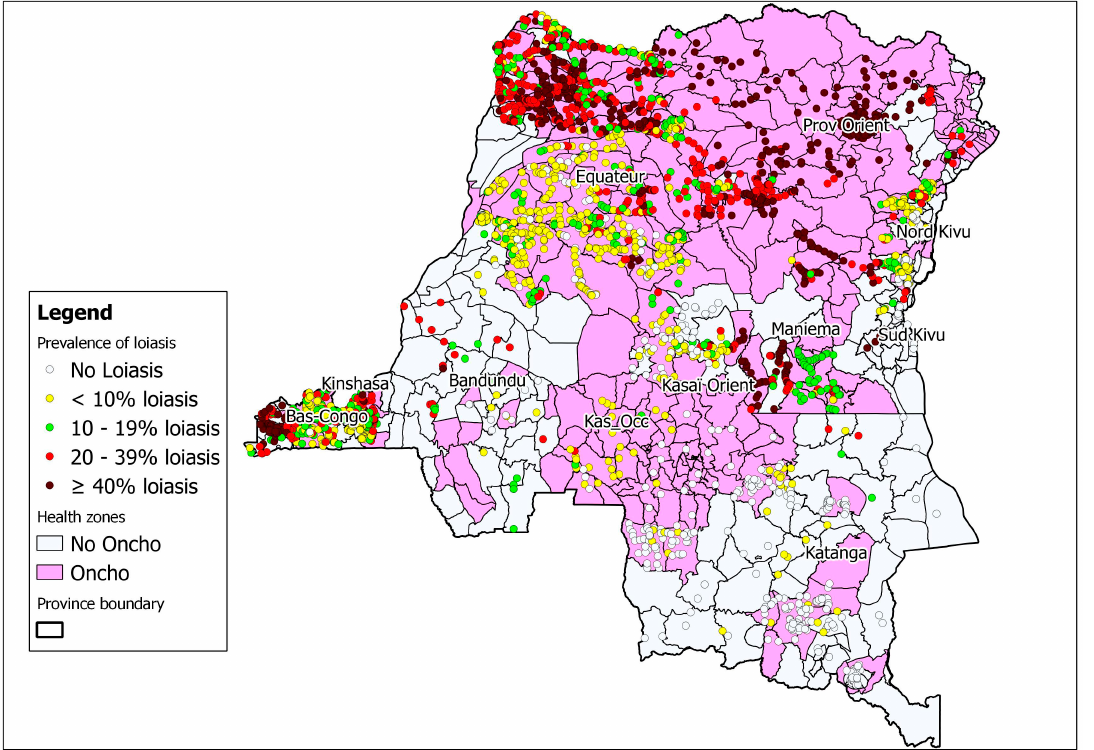
Figure 3. Map of the DRC showing areas co-endemic for onchocerciasis and loiasis (rapid assessment procedures for loiasis and onchocerciasis rapid epidemiological assessment (RAPLOA-REA)) 2012 [17]. NPCNTDs-PC functions with normative documents such as the national health policy and